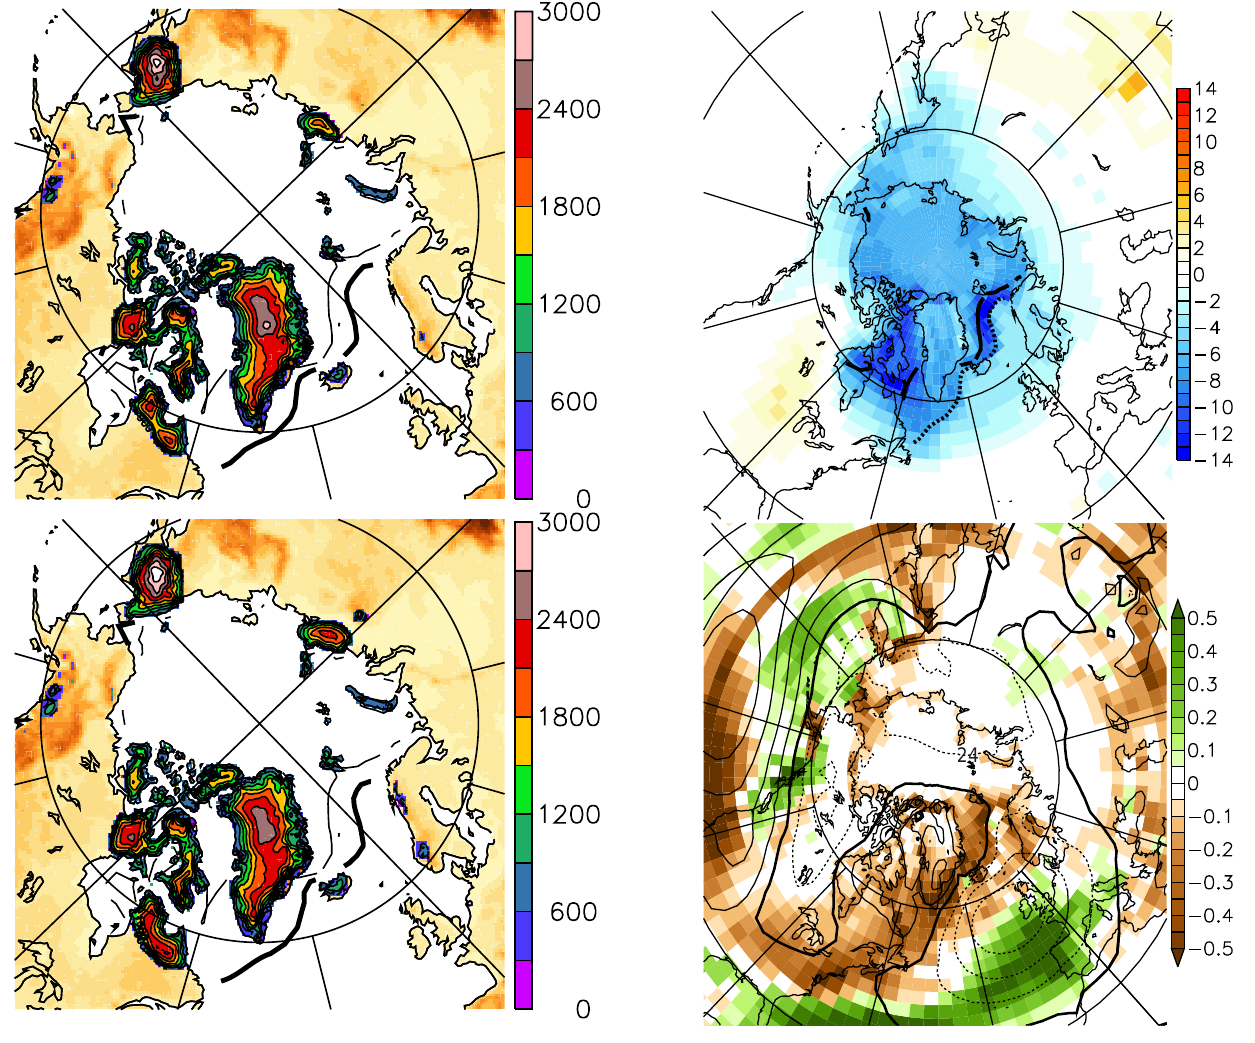
Fig. 7. Upper: Difference in annual average surface air temperature between the experiment with 3 ◦ C lower sea surface temperatures and the unperturbed 115 ka simulation (shading, in ◦ C). Annual average 50% sea ice extent is shown as contours for the unperturbed 115 ka ex- periment (solid) and with reduced sea surface temperatures (dashed). Surface air temperature differences much larger than the 3 ◦ C reduction of the sea surface are found along the sea ice edge. Scandinavian temperature changes are similar to the sea surface. Lower: Total winter precipitation (DJF, shading, in m/yr) decreases throughout the Arctic as a result of lower sea surface temperatures and a larger sea ice area. Precipitation over Scandinavia also decreases due to a change in atmospheric circulation seen as a negative anomaly in DJF sea level pres- sure (contour interval 2 hPa, negative dashed). This results in a southward shift of the Atlantic storm track and more precipitation in the Bay of Biscay region.